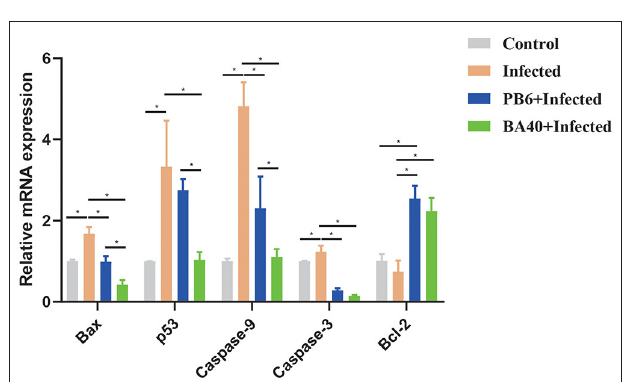
FIGURE 6 | BA40 attenuated apoptosis related gene expression. The apoptosis-related gene expression in the jejunum. The results are presented as mean ± SD ( n = 6/group, *represented significant differences P <